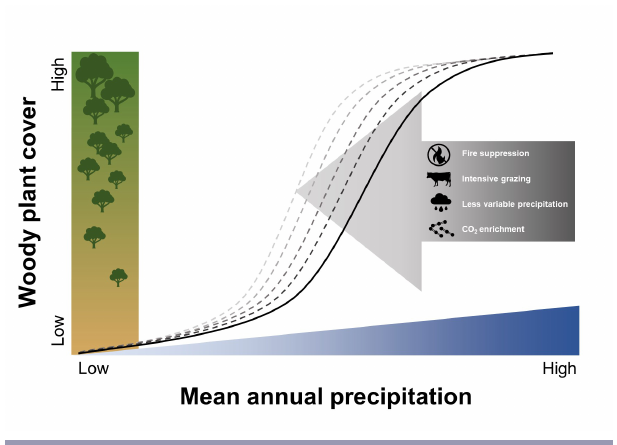
Fig. 2 . Conceptual overview of select drivers (inside arrow) impacting vegetation shifts between rangeland, woodland, and forest. Spatial and temporal changes in mean annual precipitation theoretically dictate the maximum abundance of woody vegetation, yet other factors interact to influence where the vegetation regime can shift. The solid line displays a threshold between rangeland and woodland at a higher point in the precipitation gradient due to interactions between moderate grazing, fire, variable precipitation, and lower CO transition to woodland or forest may occur more rapidly and at lower mean annual precipitation given higher atmospheric CO less variable precipitation, fire suppression, and/or overgrazing (dashed